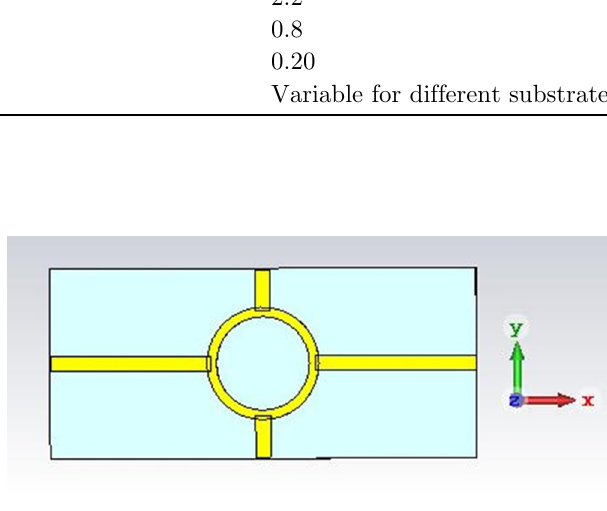
Fig. 4. Proposed MA structure.